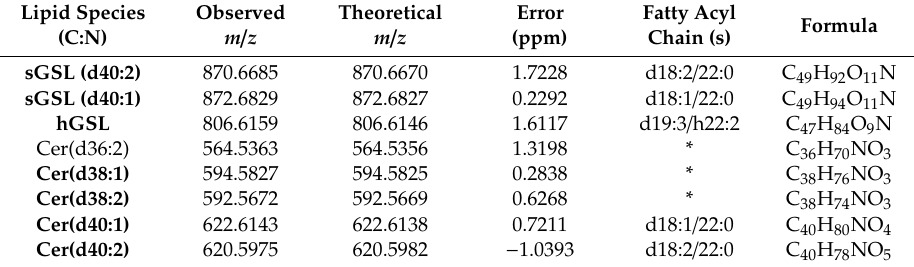
Table 7. Sphingolipid species identified by liquid chromatography–mass spectrometry (LC–MS) in positive mode as [M + H] + ions (error < 5 ppm). Identification as sphingolipids was confirmed by tandem MS (LC–MS / MS) spectra of [M + H] + ions. C represents the total number of carbon atoms and N the total number of double bonds on fatty acyl chains. The most abundant species (relative abundance > 10%) are indicated in bold. Species identified only by retention time and mass accuracy are marked with an asterisk (*). sGSL, sialic acid glycosphingolipid; hGSL, host glycosphingolipid; Cer, ceramide. Lipid Species Observed Theoretical m / z m / z (C:N) sGSL